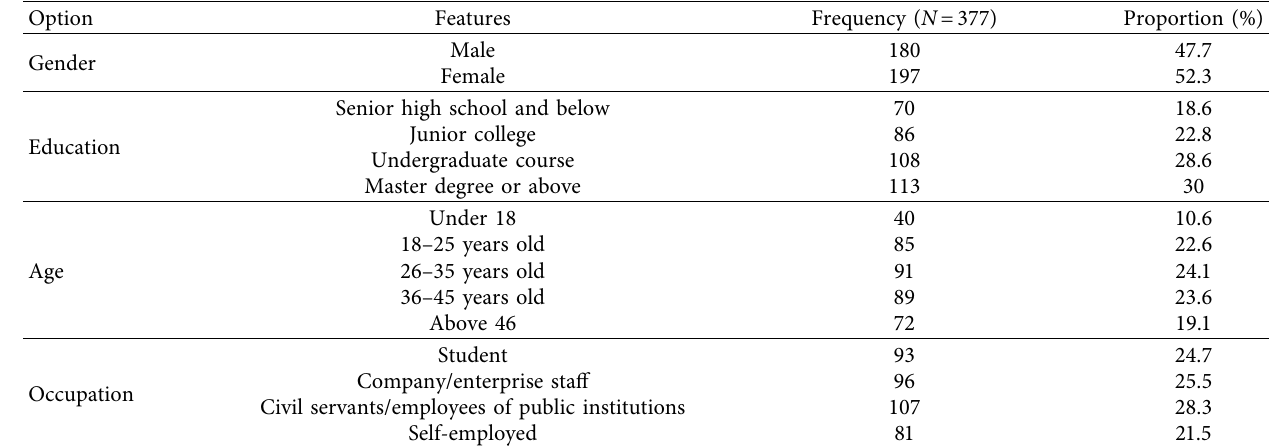
Table 2: Sample distribution characteristics.